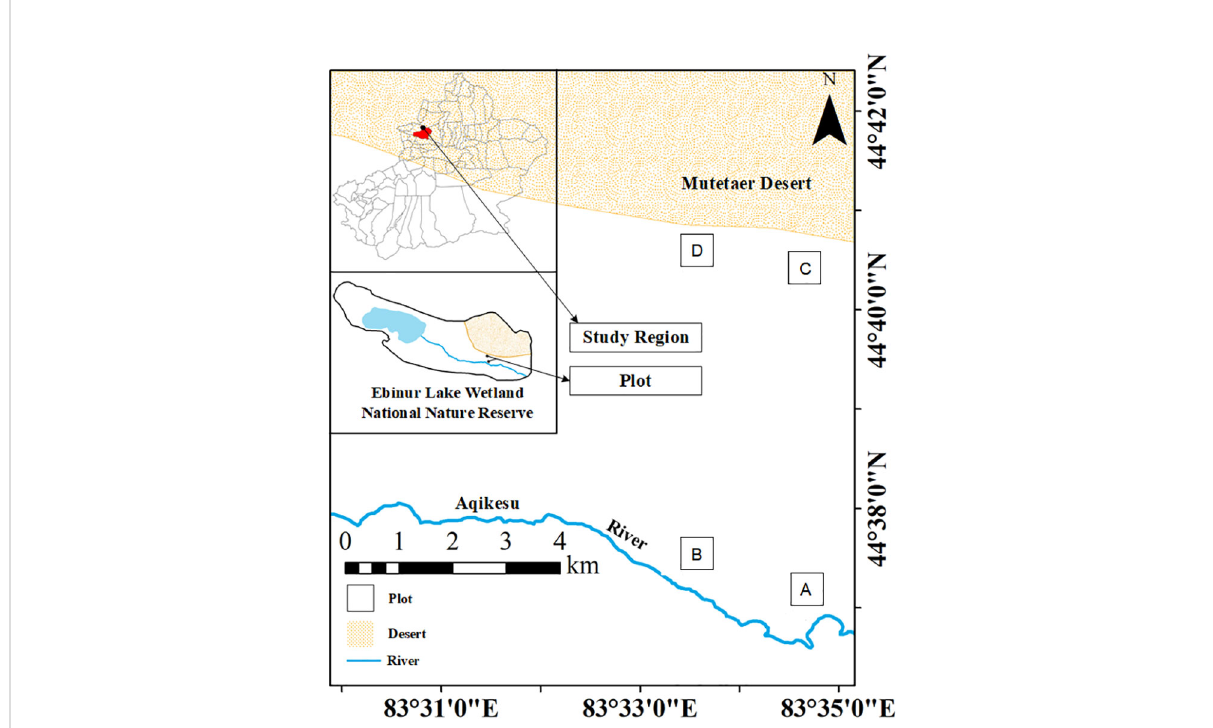
FIGURE 1 Study area and plot layout. The distribution area of H. ammodendron : (A) : humid and low salinity, and (B) : arid and low salt; the distribution area of H. persicum : (C) : humid and low salinity, and (D) : arid and